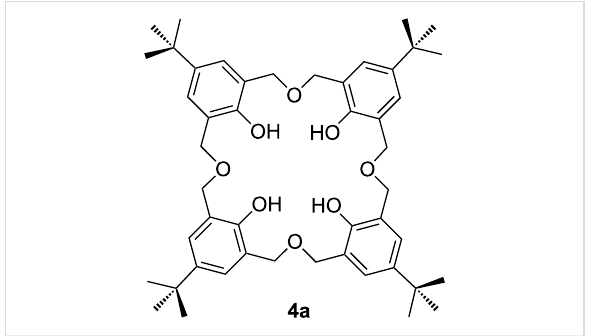
Figure 3: p - tert -Butyloctahomotetraoxacalix[4]arene ( 4a ) [16].